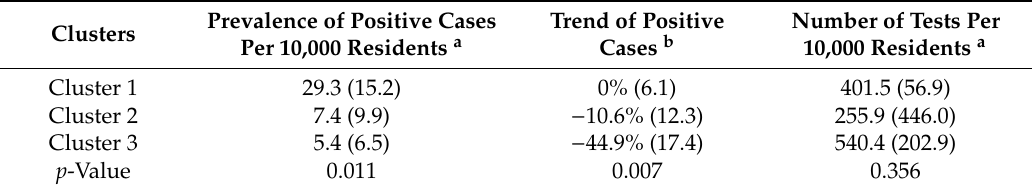
Figure 4. Scatter plot illustrating how the egional clusters were distributed on the prevalence of SARS-CoV-2 positive cases and their trend. Clustering solution was obtained by the hierarchical clustering and consolidated by the k-means algorithm. Table 3. Comparisons of the prevalence of SARS-CoV-2 positive cases, their trend and the number of tests between regional clusters.